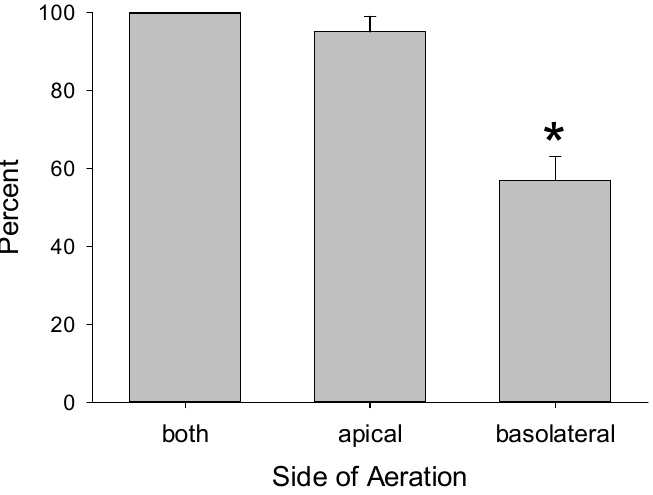
Figure 2. Fluid flow by mouse enterocytes cultured on inserts with 12 µm pores was measured when only the apical and then only the basolateral chamber was vigorously aerated. Values are expressed as the percentages of the fluid flow when both chambers were aerated ( n = 6 inserts with three inserts from each of two preparations of mouse enterocytes). The asterisk indicates that aeration of only the basolateral chamber resulted in lower fluid flow compared with aeration of the apical or both chambers, which were equal.